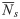
Schematic for calculation of ‘average N
s’ (N¯s).Illustration of procedure for calculating the average N
s for a given cuisine. Beginning with an individual recipe, average N
s of the recipe (NsR) was calculated. Averaging NsR over all the recipes returned N¯s of the cuisine.